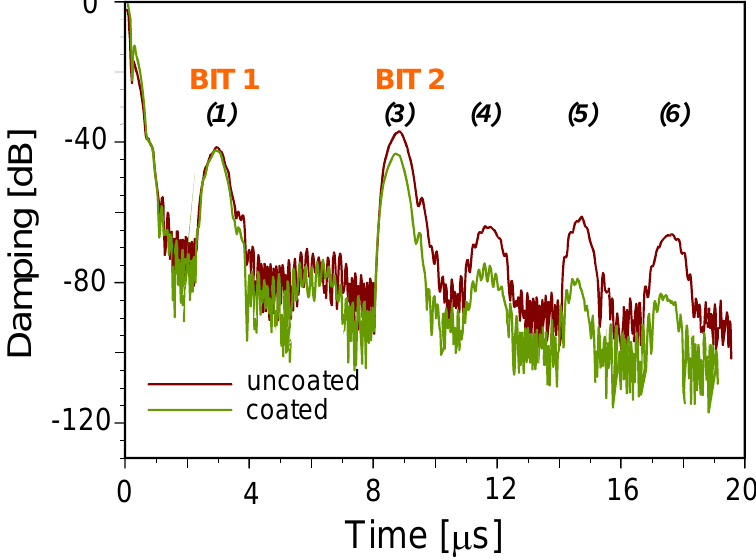
Figure 4. Sensor response in time domain—identification code of the uncoated (red line) and the PVA-coated (green line) RFID-Tags,